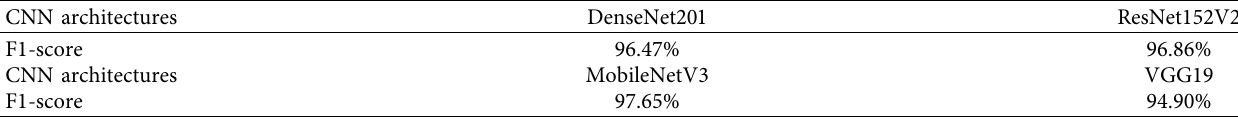
Table 7: Accuracy of network architectures based on F1-score using ADAS optimization function.